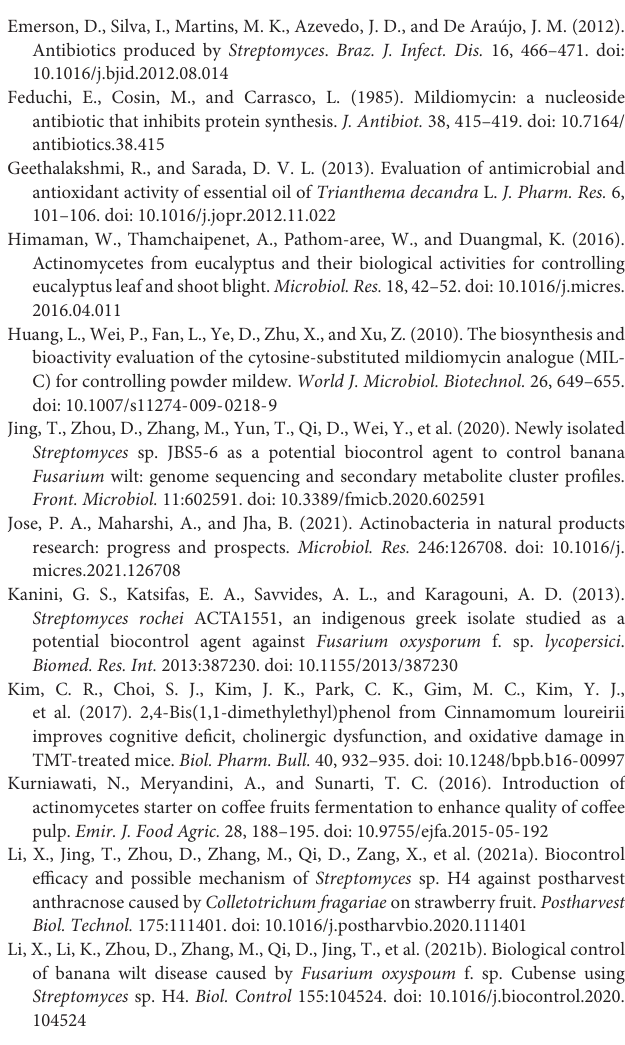
Supplementary Figure 1 | Total ion current chromatograms of strain H3-2 extracts. Supplementary Figure 2 | Symbiotic experiment of strain H3-2 with endophytic bacteria isolated from banana roots. Different numbers below the pictures represent the diverse endophytic bacteria. Strain H3-2 is first cultured on the YE medium for 2 days, and then each endophytic bacterium is inoculated using a cross method. After co-culture for 24 h, the symbiotic result is observed. The experiment is performed in triplicates. Supplementary Table 1 | Growth characteristics of strain H3-2 on different solid culture media. Supplementary Table 2 | Physiological and biochemical characteristics of strain H3-2. Supplementary Table 3 | Carbon and nitrogen source utilization of strain